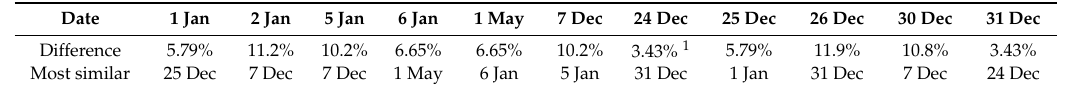
Table 8. Differences between special days type 1 and 2.